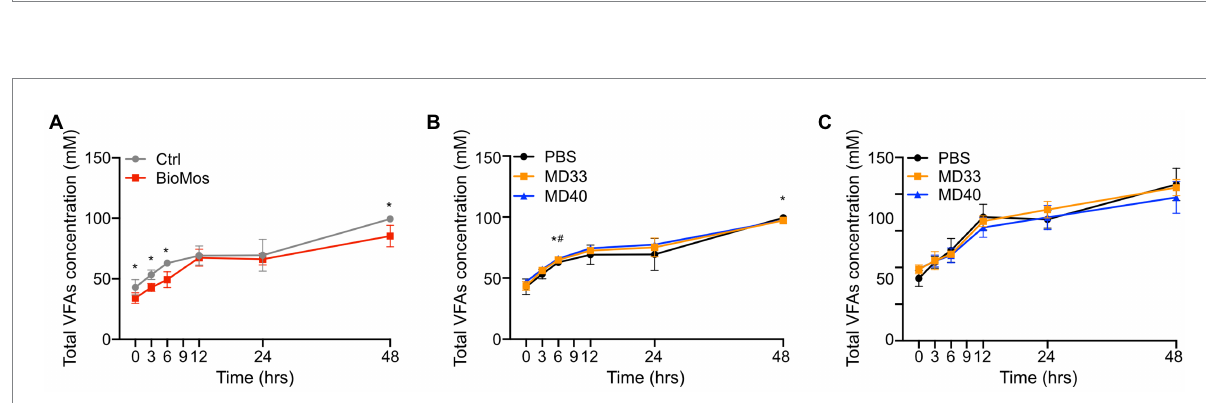
FIGURE 5 Total volatile fatty acid production of ex vivo rumen systems. (A) VFA concentrations in control (grey) and Bio-Mos® (red) samples. *Signifies statistical difference between diet samples. (B) VFA concentrations of probiotic inoculations of rumen samples taken from cows fed a control diet. (C) VFA concentrations of probiotic inoculations of rumen samples taken from cows fed a Bio-Mos® enriched diet. *Signifies statistical difference ( p < 0.05) between the PBS and MD33 treatments. # Signifies statistical difference ( p < 0.05) between the PBS and MD40 treatments. N =